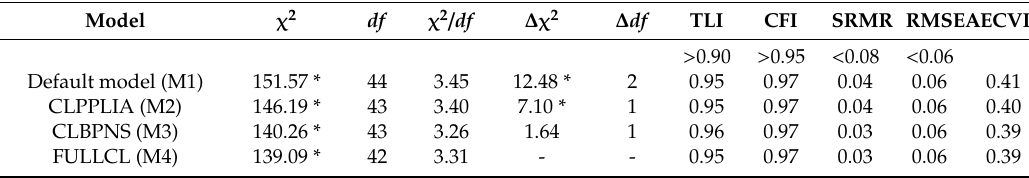
Table 3. Cross-lagged standardized regression paths and autoregressive paths.